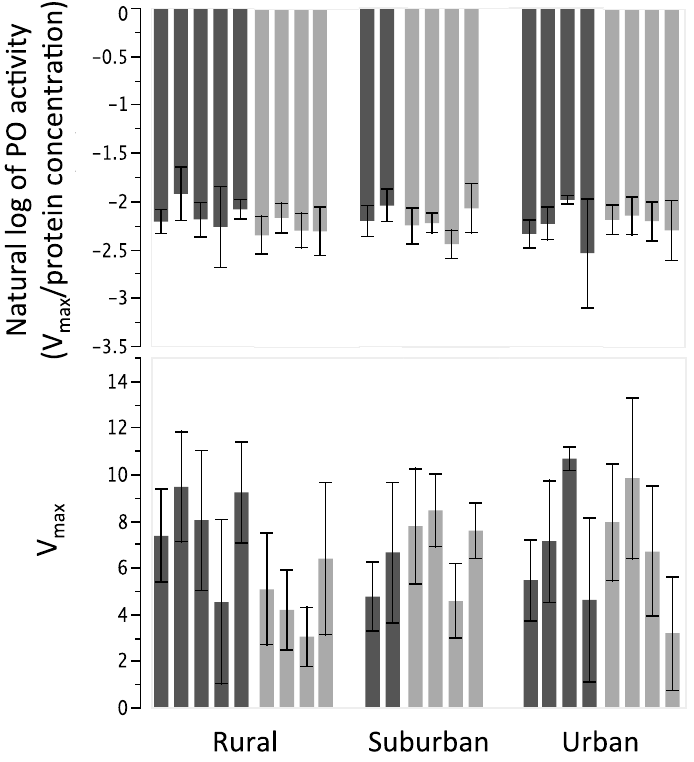
Figure 4. Bar graphs of each colony (mean ± SD) for measures of phenoloxidase activity. Bars plotted as in Figure 3. ( Top ) Phenoloxidase activity as measured by V max /(protein); ( Bottom ) Phenoloxidase activity as measured by V max